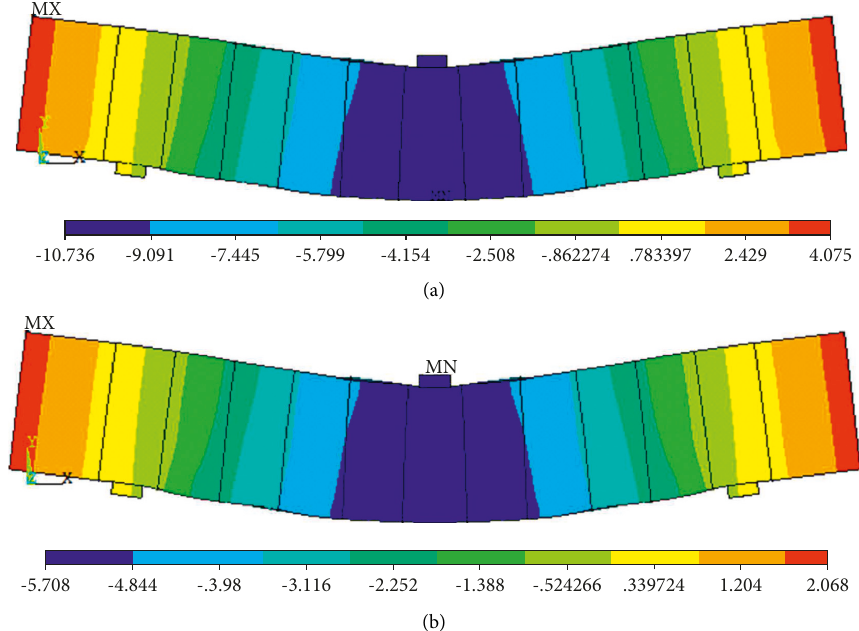
Figure 16: FE model deflections throughout the beams. (a) A2.5RC10/10. (b) A2.5F2.0C10/10.